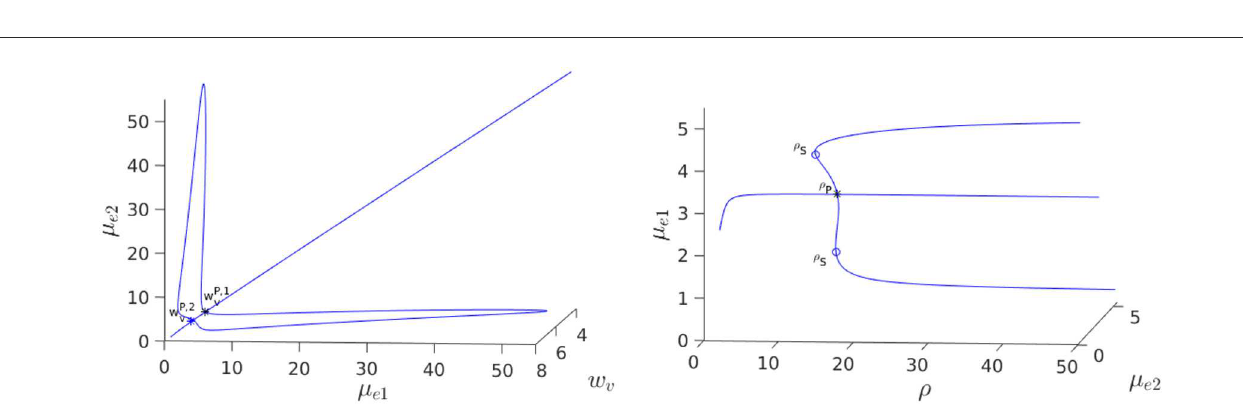
FIGURE12 3-D Bifurcation diagram, computed from Equation (4.8) using MatCont [51], for symmetric and asymmetric steady-states of a two-cell ring pattern with d v / d u ring radius r 0.5 and with RM kinetics Equation (4.7). Left: 3-D Plot of ( µ e 1 , µ e 2 ) vs. the kinetic parameter w v in Equation (4.7) at a fixed ρ 15, = = = showing that asymmetric steady-states occur inside the degenerate pitchfork bubble delimited by w P ,1 v 6.88285 and w P ,2 v 7.08723. Note that the ≈ ≈ bubble lobes are stretching into decreasing w v and that there exists hysteresis at w P ,2 v . Right: In terms of ρ , a supercritical pitchfork bifurcation from the w P ,2 v symmetric branch occurs when w v 7.08723. The asymmetric branches are linearly stable past this bifurcation threshold in ρ . Parameters: = ≈ D u D v c v 1, σ u 0.1, ε 0.03, c u 1, q u 1 / 100, q v 7, a u 1 600, a u 2 6, b u 1 100, b u 2 1 / 10, and d u σ v = = = = = = = = = = = = = =